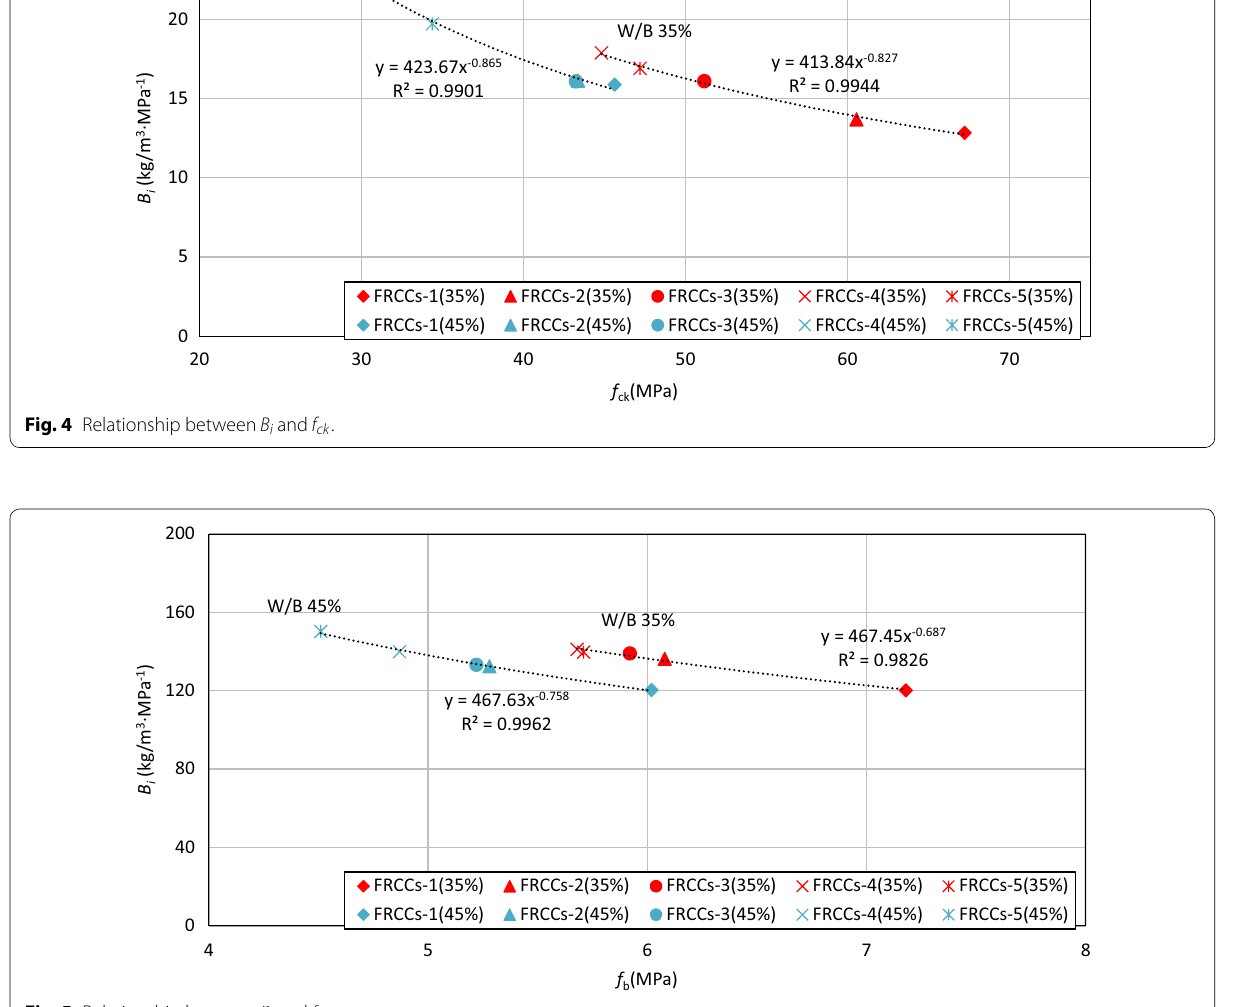
Fig. 5 Relationship between B i and f b